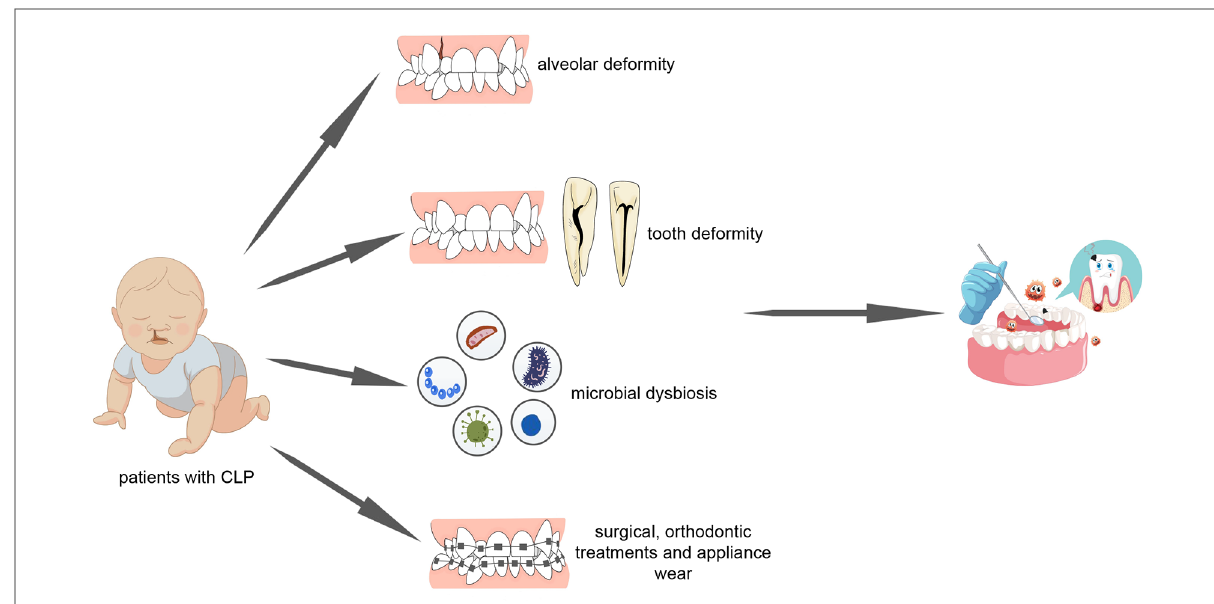
FIGURE 2 Patients with cleft lip and palate undergo poorer oral hygiene as a result of alveolar deformity, tooth deformity, microbial dysbiosis, surgical repair, orthodontic treatment and appliance